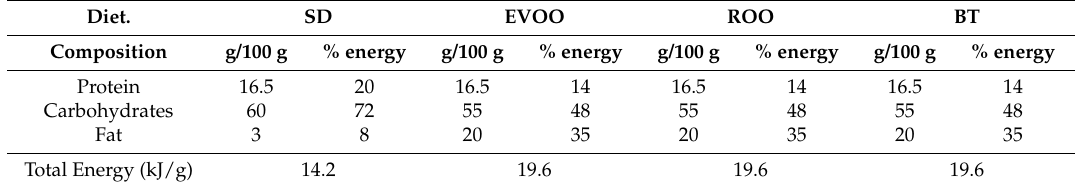
Table 1. Nutrient composition and energy content of standard (SD) and high-fat diets enriched with extra virgin olive oil (EVOO), refined olive oil (ROO) and butter (BT).